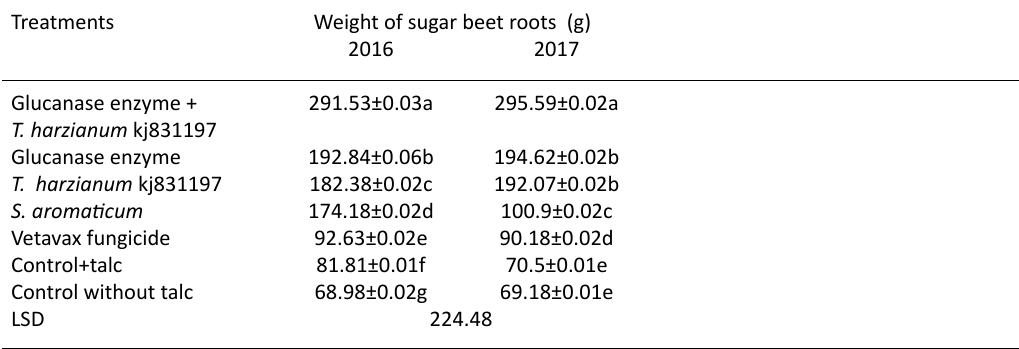
table 3. Effect of different treatments on weight of sugar beet roots under greenhouse conditions during growing seasons Treatments Weight of sugar beet roots (g)